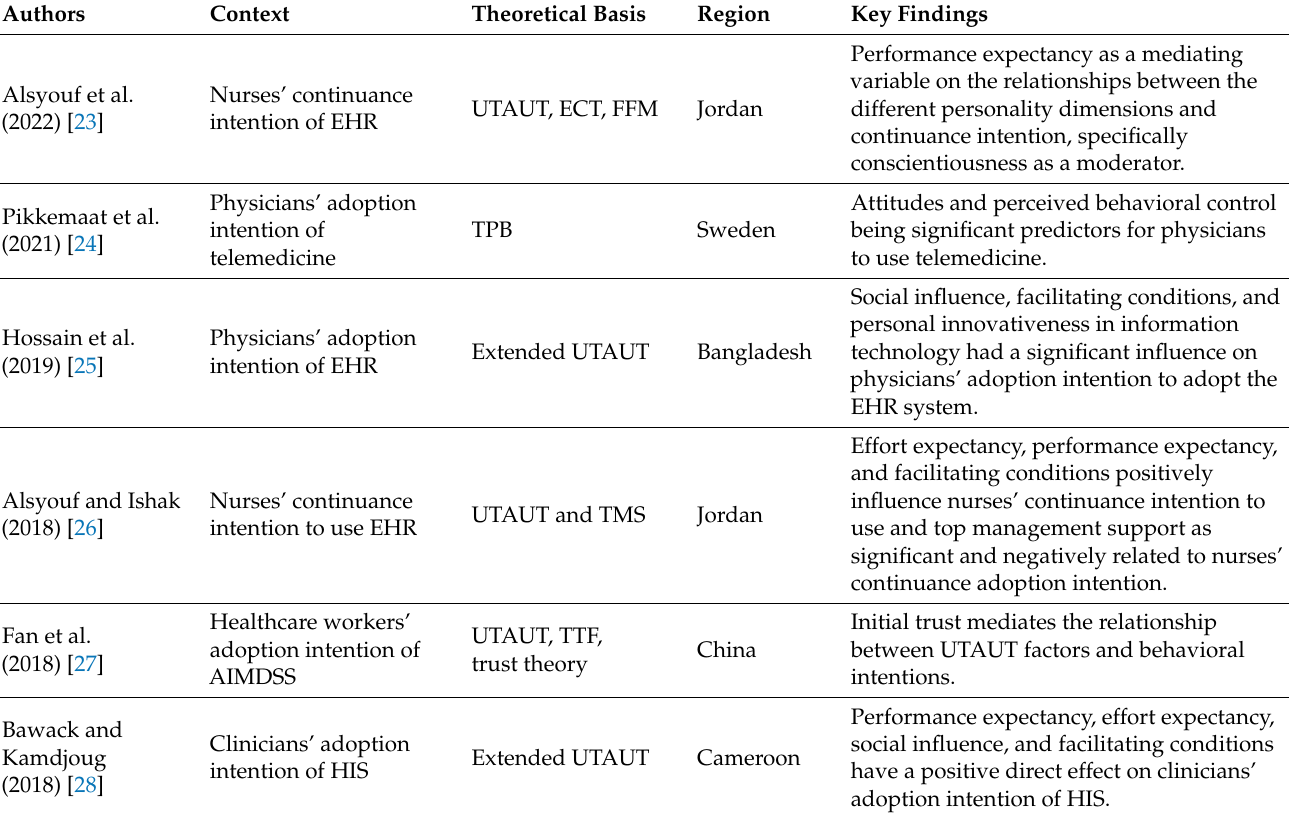
Table 1. Literature review on healthcare workers’ adoption